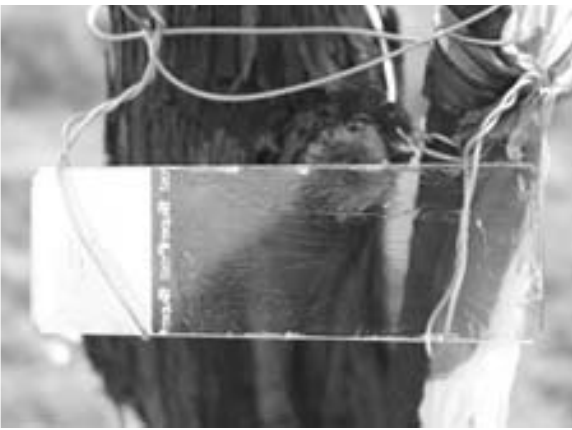
Fig. 1. Spore trap slide coated with silicone gel and af fi xed near an old pruning cut.